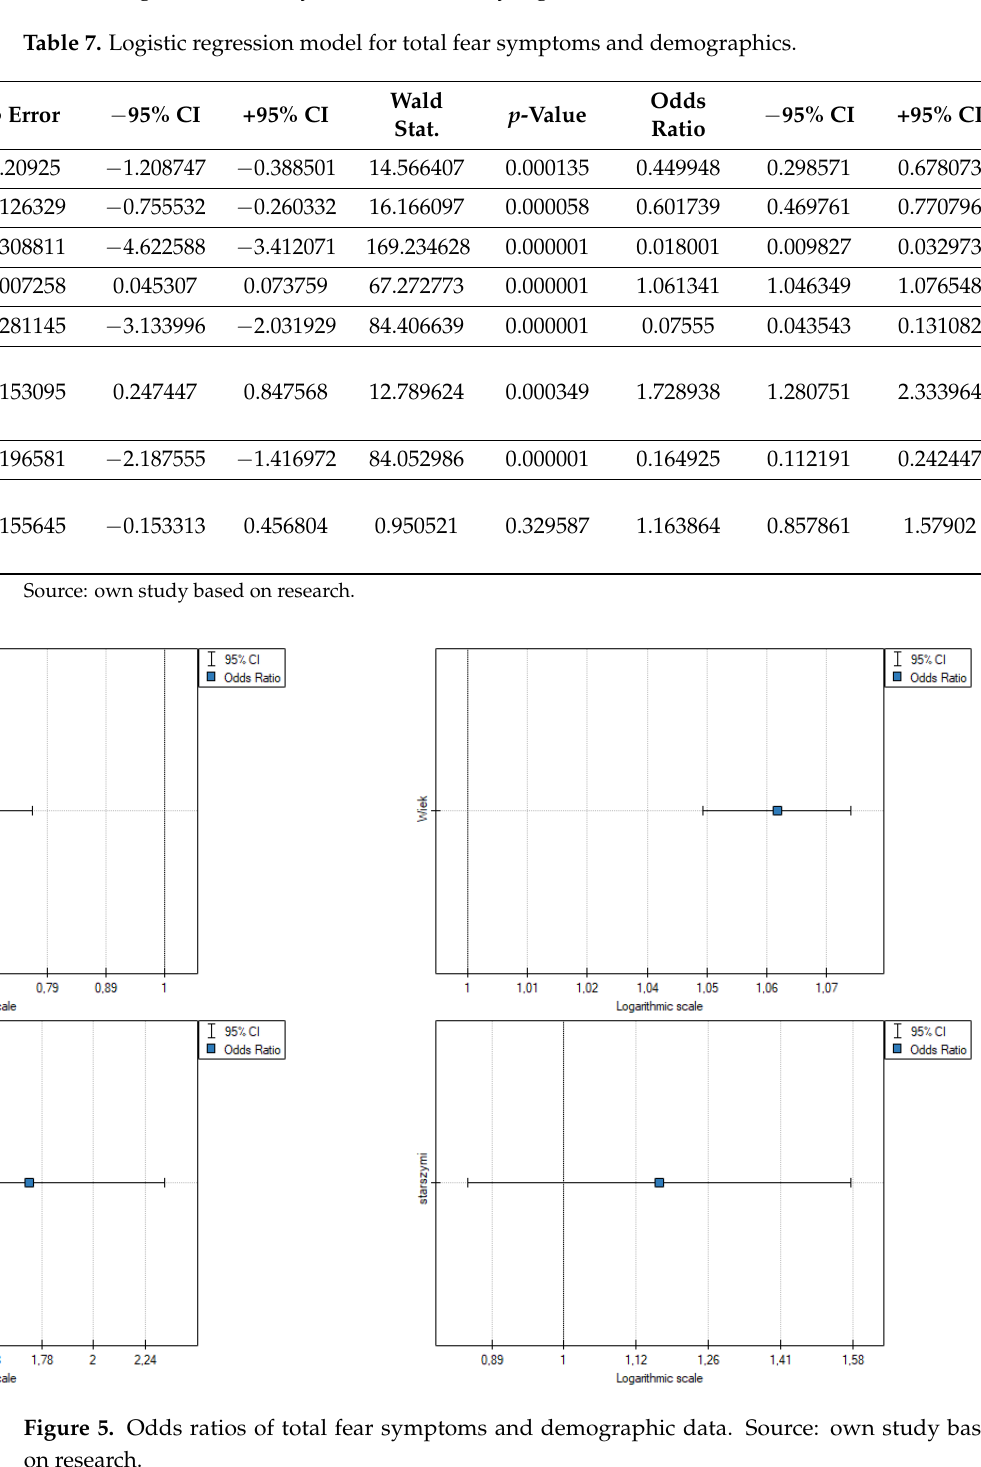
Table 8. Logistic regression model for psychological (emotional) symptoms of fear and three age groups. Mental